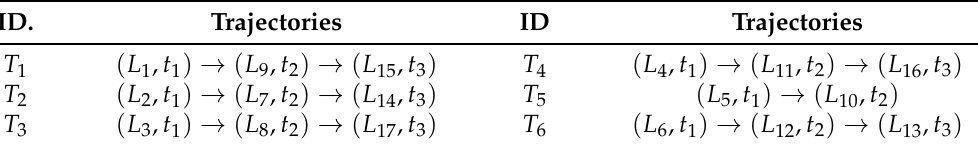
Table 1. Original trajectory